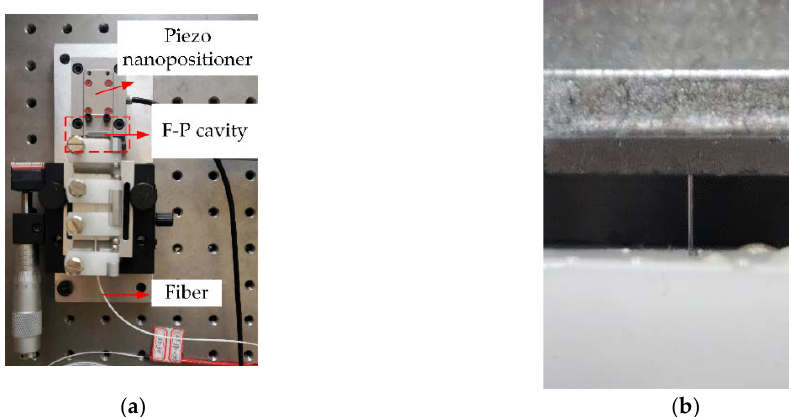
Figure 13. F-P cavity structure: ( a ) F-P cavity system composed of optical fiber and quartz glass slide; ( b ) Local structure of F-P cavity.